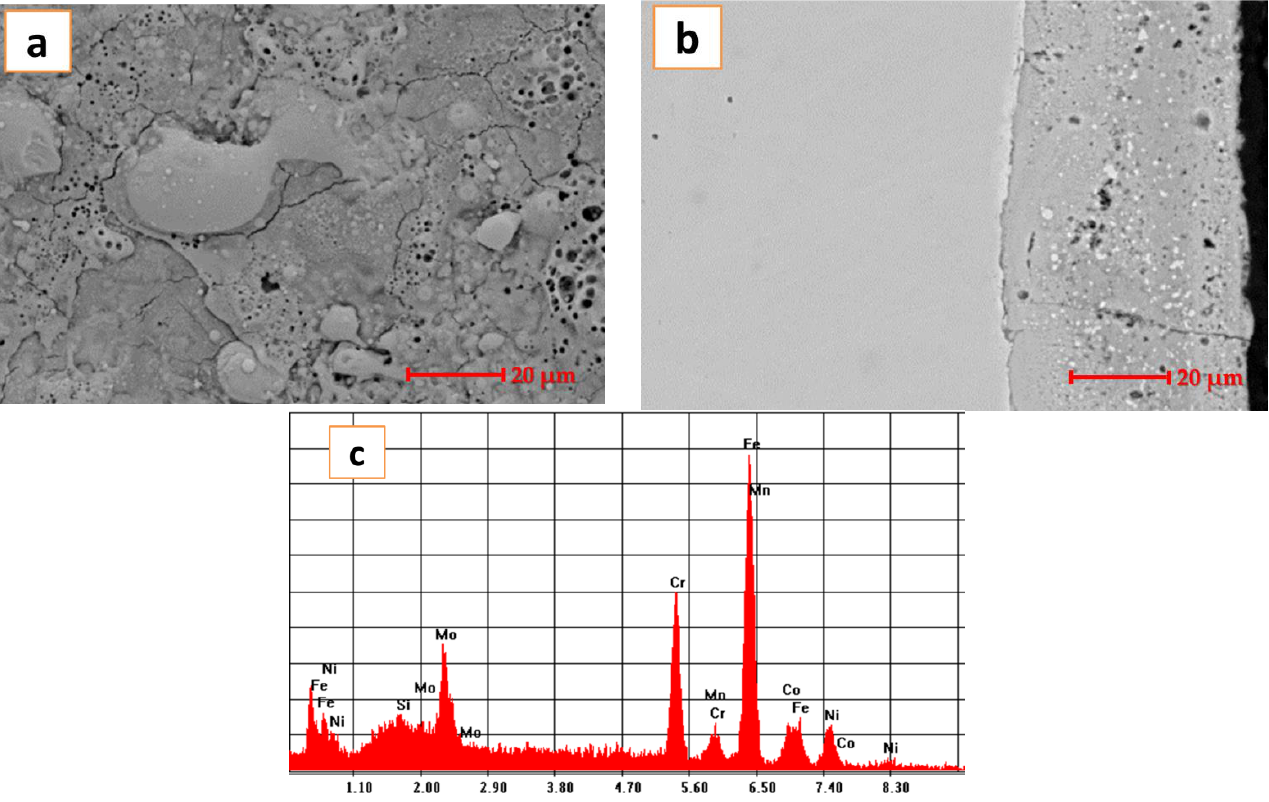
Figure 3. Analyses results of CoCrFeNiMo 0.85 HEA pressed and sintered ( a ) SEM image of the sintered sample, ( b ) EDS analyses for zone 1 and ( c ) EDS analyses for zone 2. The coating obtained with the processed electrodes is presented in Figure 4.